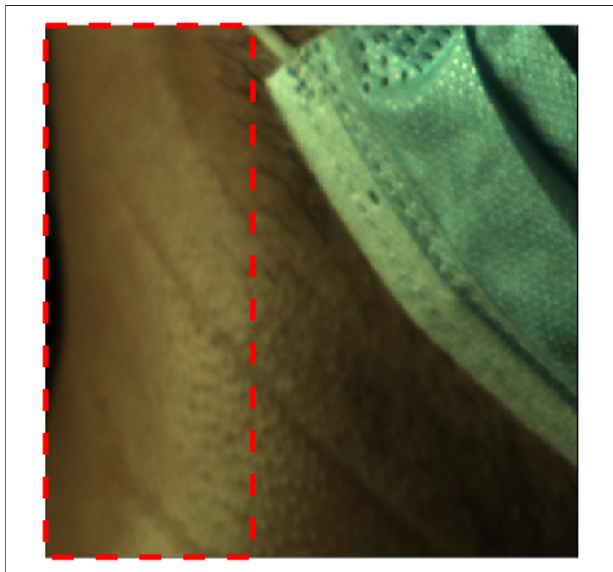
FIGURE 7 | Framing and region of interest (red rectangle) that excludes the mask.